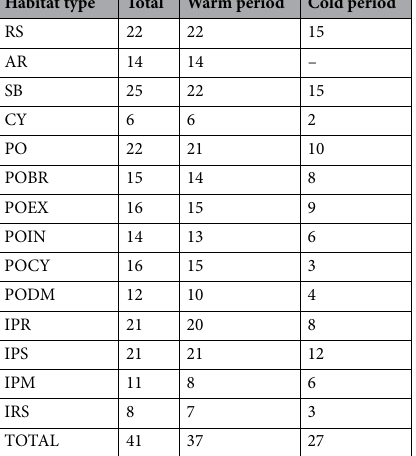
On the plane defined by axes 1 and 2, some PODM stations were gathered with rocky habitats due to a high cover percentage of macrophytes, especially bushland communities (Table S1), but all PODM stations tightly clustered together on the positive part of axis 4, which was correlated with a high dead matte percentage. All interfaces were positioned on the PCoA plan at a logical but well-individualized place testifying to their particu- lar identity: IPR between Posidonia and rocky substrates on the positive part of axis 1 and negative part of axis 2, IRS between rocky and soft substrates on the positive parts of both axes, IPS and IPM on the negative part of axis 1, as correlated to high sand and dead matte percentages respectively. Mean values (± SE) of the abiotic and biotic descriptors of the 14 individualized habitat types are given in Table S1, along with their significant seasonal variations. Abiotic descriptors rarely changed with period whatever the habitat and were related to the haphazard position of sampling units, while biotic habitat descriptors presented consistent seasonal variations linked to the biology and growth of macrophytes. Higher cover percentages and canopy height of seagrasses and macroalgae were generally recorded in warm rather than in cold period, except for turf/encrusting and wrecked algae, which increased the three-dimensional structure of these habitats (Table S1). However, differences were statistically significant only in a few habitats due to the high variance of data. Juvenile fish assemblages. A total of 526,014 juvenile individuals, belonging to 57 different fish species/ taxa and 22 families were recorded (Table S2). As small juveniles of particular genera such as Symphodus, or families such as blenniids and gobiids, were difficult to identify precisely underwater, they were grouped into 41 taxa for analysis. A higher total species richness of juvenile fish was recorded during the warm (37 taxa, n = 1 376) than the cold (27 taxa, n = 725) period and differed among habitats (Table 4). The highest total number of taxa was recorded on soft bottoms (25 taxa, n = 426), followed by rocky substrates and Posidonia beds (22 taxa each, n = 428), while the lowest number of juvenile fish species was observed in Cymodocea beds (6 taxa, n = 116). The most abundant taxa included by decreasing order of importance unidentified larvae, Atherina sp., Sarpa salpa , Gobiidae, Symphodus spp., Diplodus vulgaris , Pagellus spp., Diplodus annularis , Oblada melanura and Dip- lodus sargus (Fig. 3). They were observed in most habitats (from 7 habitats for Pagellus spp. to 14 for D. vulgaris ), while 13 taxa were recorded in only one habitat type, generally with low abundance (Table S3). Four taxa were only recorded on rocky substrates ( Boops boops, Epinephelus marginatus , Thalassoma pavo and Tripterygiidae) and four on soft bottoms ( Arnoglossus spp., Bothus sp., Solea sp. and Trachinidae). Most species (23 spp.) were observed at both periods, and a higher number were recorded only in warm than only in cold periods (14 spp. vs 4 spp., respectively) (Fig. 3). Mean species richness per sample varied from 0.25 to 3 taxa per 10 m 2 and differed according habitats and periods. The significant interaction of the two factors indicated that between-habitat variability differed between seasons (PERMANOVA, F = 6.506, P < 0.001, Table 5). Mean species richness was highest on natural and arti- ficial rocky substrates and lowest in Cymodocea beds (Fig. 4). Interfaces Posidonia /other habitats (IPR, IPS and IPM) presented a higher mean species richness than the different habitats of P. oceanica bed and barrier reef, demonstrating the particular importance of ecotones for juvenile fishes. The mean species richness tended to be higher during the warm than the cold period, in all but POIN habitat, where a lower mean species richness was recorded in summer (Fig. 4). As schools of larvae and Atherina sp. could be numerous and haphazardly dispersed in space and time, they might mask the effect of period or habitat on relative abundance. Atherina sp. were more abundant during the warm period and were present in 12 habitats, while undetermined larvae were observed in higher abundance during the cold period and present in 13 habitat types. They were thus excluded from the analysis of juvenile abundance to obtain clearer patterns. The total density of juvenile fishes also varied significantly between habitats